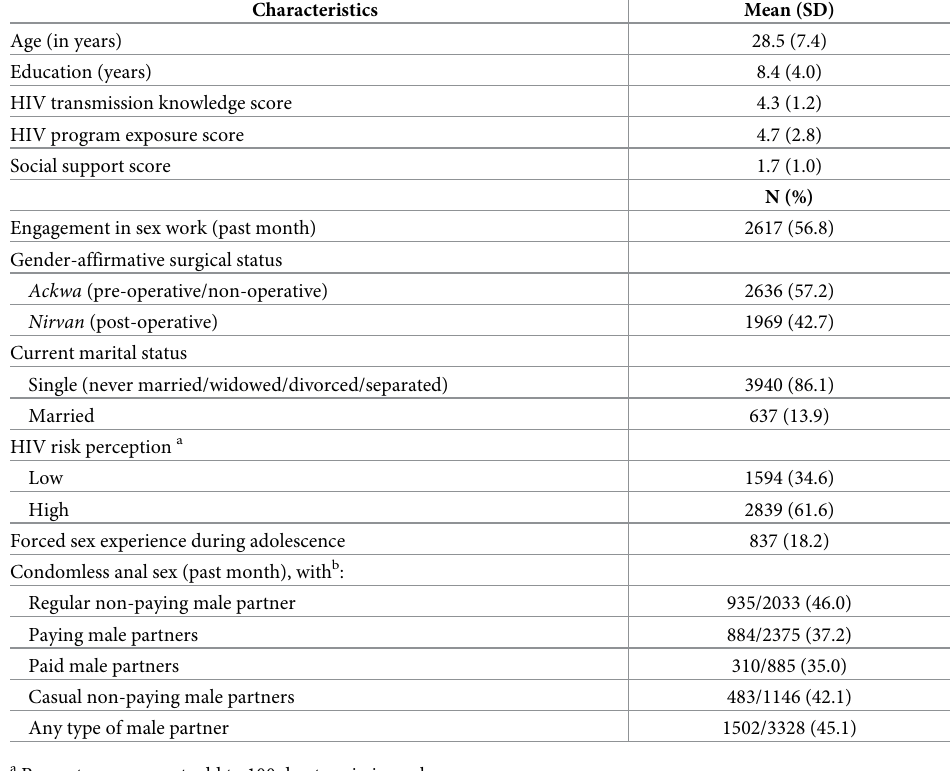
Table 2. Characteristics of HIV-negative transgender women who participated in the Integrated Biological and Behavioural Surveillance (IBBS) study, 2014–15 (N =